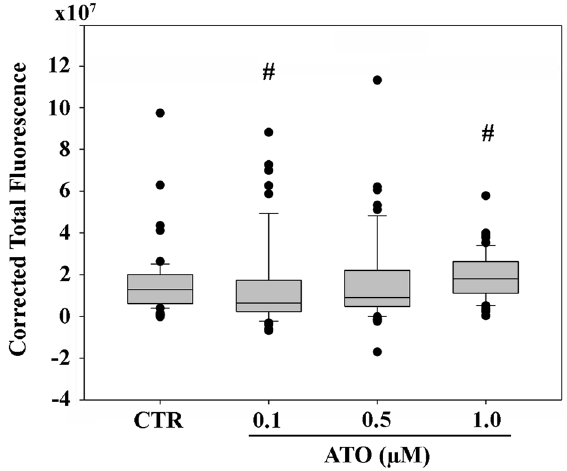
Figure 5. Corrected Total Fluorescence of cardiac α-actinin signals corresponding to the volume occupied by the cardiomyocyte tissue in EB core samples. The horizontal line in the box is the median, whereas the upper and lower lines are the 25th percentile and 75th percentile, respectively. The black dots are out-layer values. CTR, control; # p <